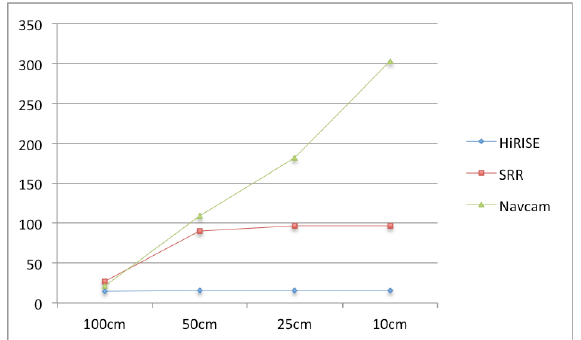
Figure 16 Rock frequency-size distribution for HiRISE, SRR and Navcam at MSL Sol 416.